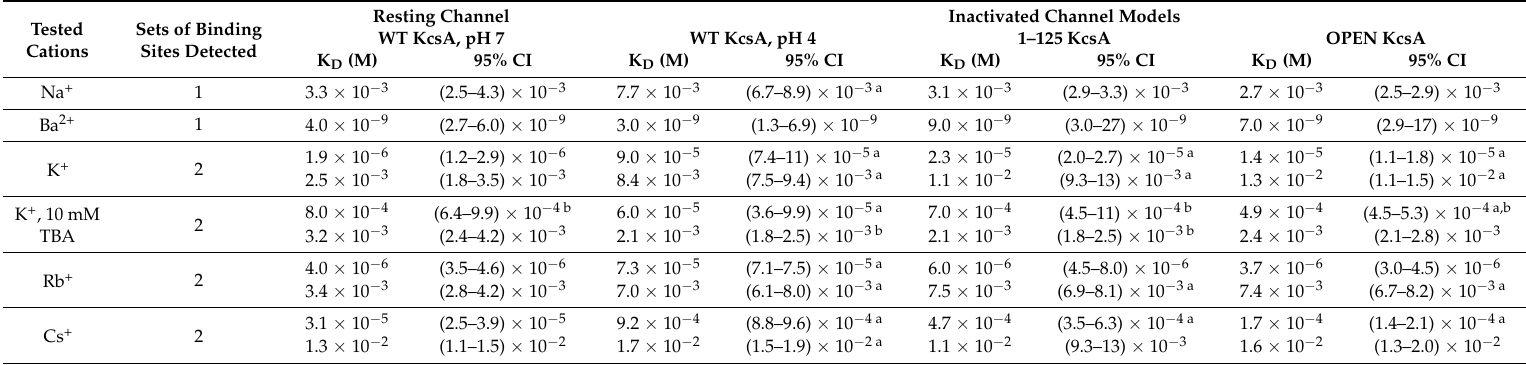
Table 1. Apparent dissociation constants (K D ’s) for the binding of different cations to the resting and inactivated state models of the KcsA channel. Mean values given here come from the experiments reported in Figures 3–7. Since the estimated K D values are derived from a logarithmic function (Equation (1)), we use the 95% confidence intervals of these values for statistical comparisons, instead of giving mean ± SD values, since only parametric analysis is appropriate on the logarithmic scale for such data. a Significant differences with respect to the resting WT, pH 7 group ( p < 0.05). b Significant differences with respect to the same sample without 10 mM TBA ( p <